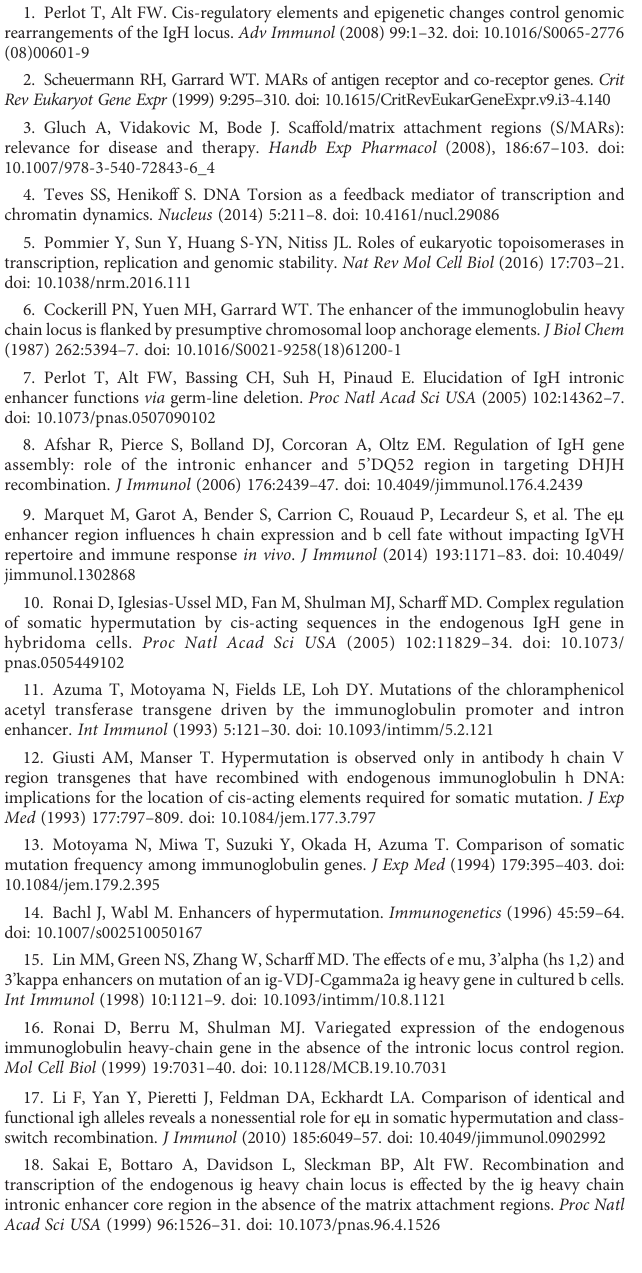
SUPPLEMENTARY TABLE 1 MARs Eμ deletion led to normal B-lineage cell development. Bone Marrow and peripheral B cell subsets counts in wt and MARs Eμ D / D mice. Absolute numbers are reported as mean± SEM. Signi fi cance was assessed with Student T test. P value is indicated when difference is signi fi cant. SUPPLEMENTARY TABLE 2 SHM data(NGS)from individualmice inDNArepairpro fi cientbackground. Total number of mutations, total number of bp analyzed and mutation frequencies for w t and MARs Eμ D / D mice. (A) Data from intron 3 ’ to J H 4 in Peyer ’ s patches GC B cells, (B) Data from spleen GC B cells from SRBC-immunized mice, (C) Data from intron 3 ’ to Iµ in Peyer ’ s patches GC B cells. SUPPLEMENTARY TABLE 3 Unselected SHM within out of frame VDJ exons in GC B cells sorted from Peyer ’ s patch. Unique VDJ junctions, rearranged to J H 3 and J H 4 segments, were obtained